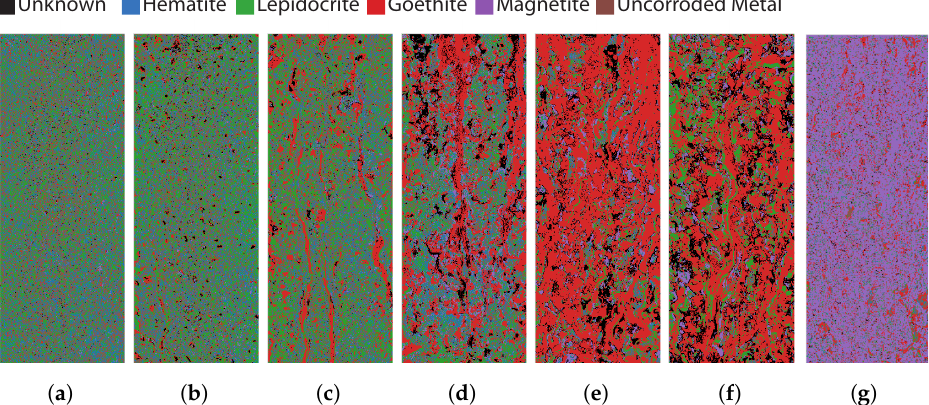
Figure 5. Classification results based on the Normalized Cross Correlation of the different samples. ( a ) Sample 1; ( b ) Sample 2; ( c ) Sample 3; ( d ) Sample 4; ( e ) Sample 5; ( f ) Sample 6; ( g ) Sample